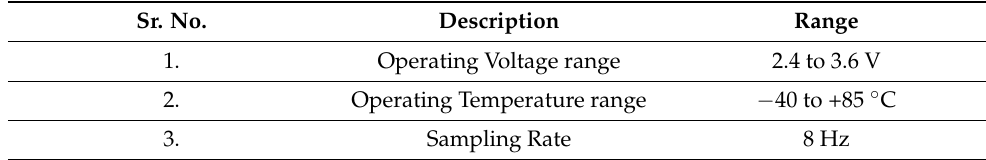
Table 3. Data Logger